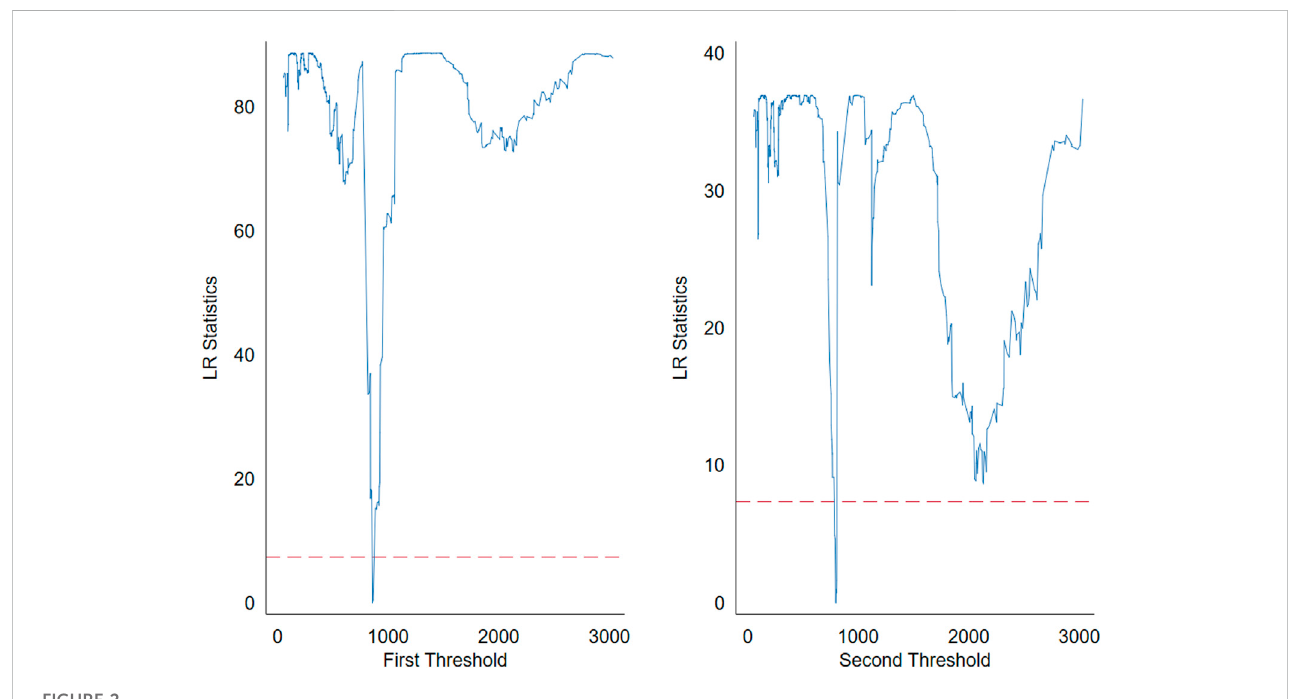
FIGURE 2 Threshold estimate and con fi dence